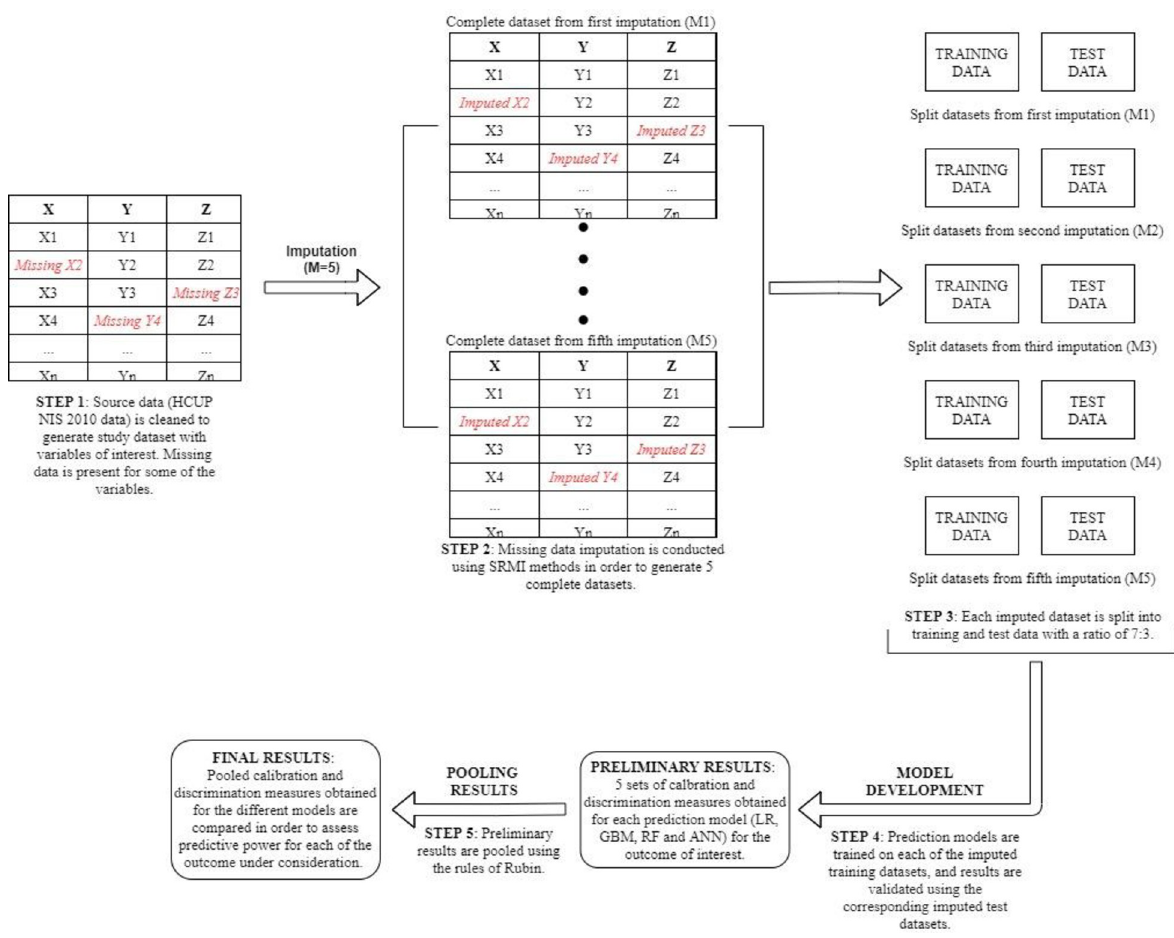
Fig 1. An illustrative flowchart of the development and validation of predictive models.